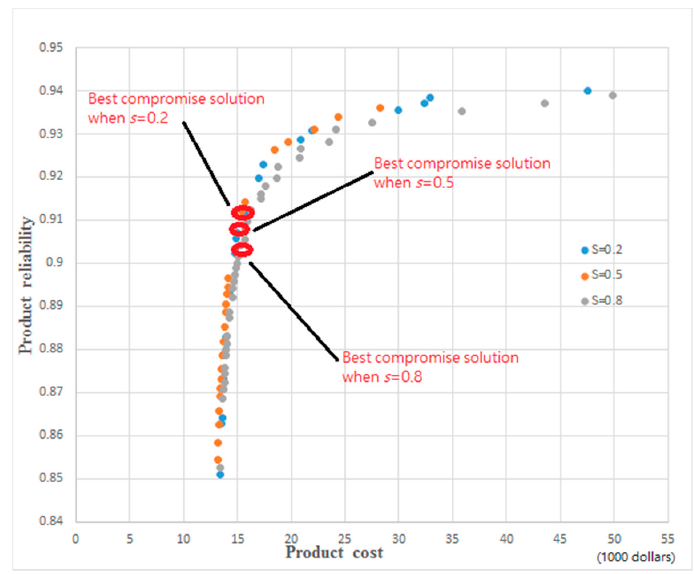
Figure 10. Partial Pareto fronts containing the best compromise solution with s .